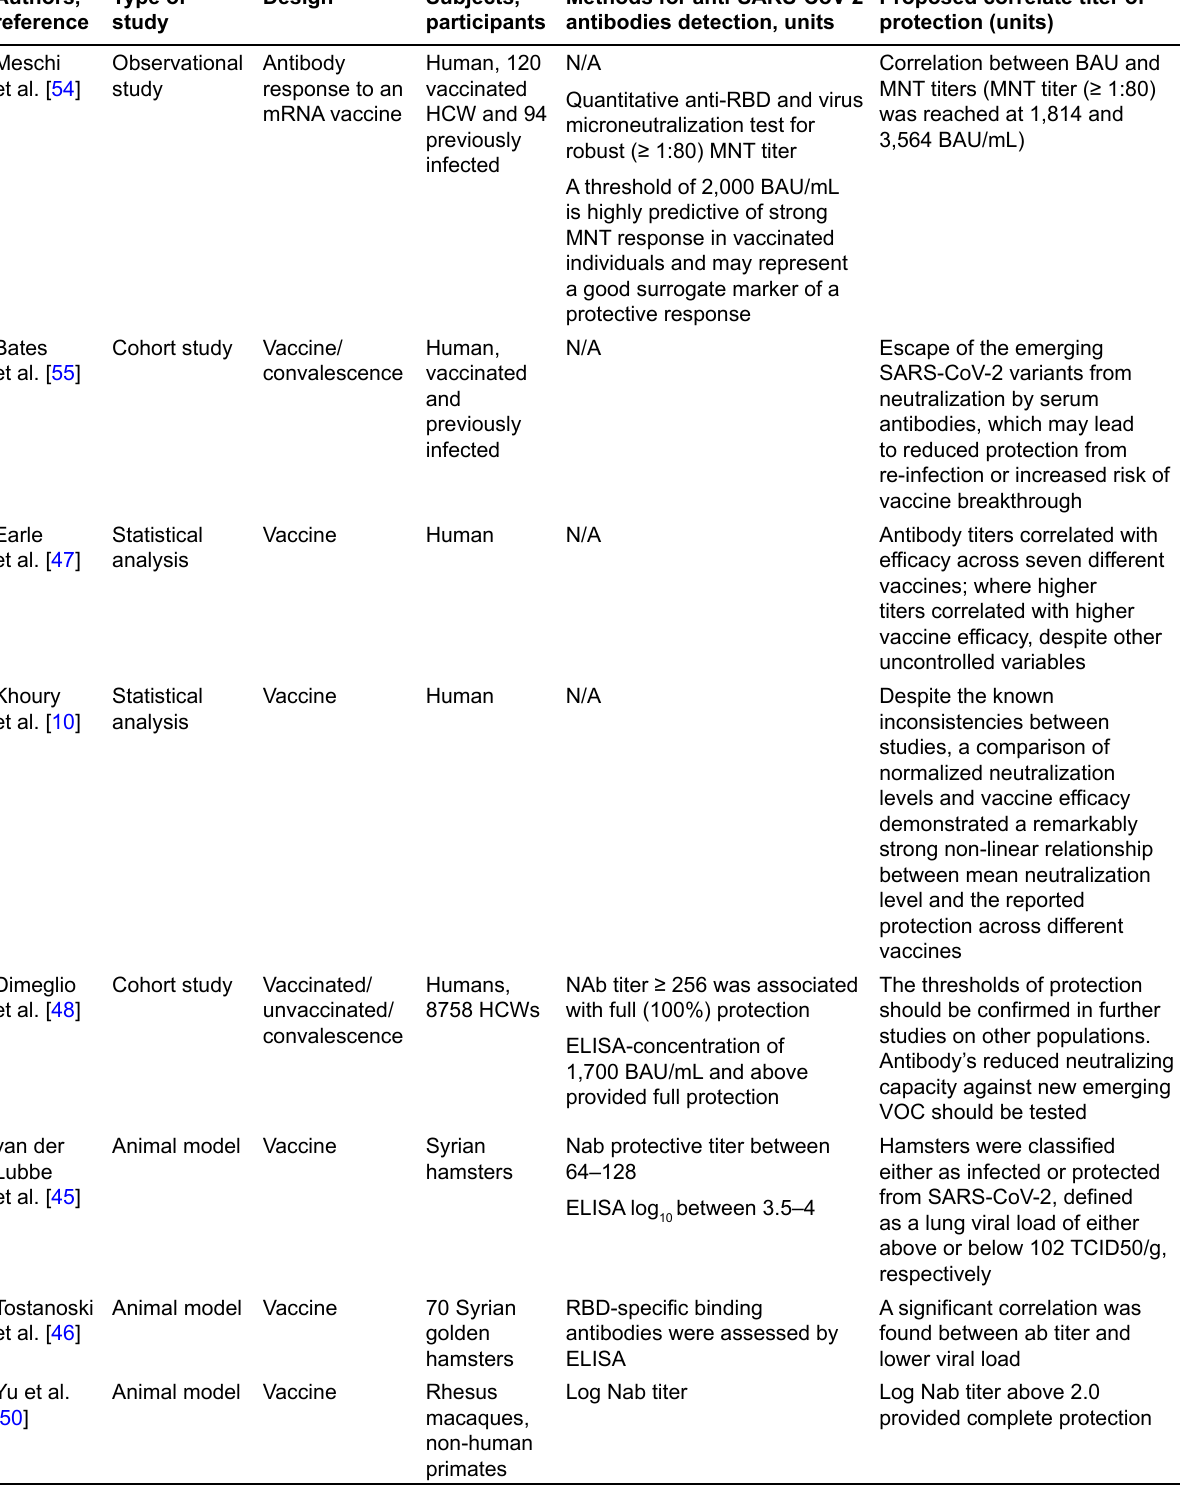
Table 1. Correlates titer of protection against SARS-CoV-2 proposed by different study groups ( continued